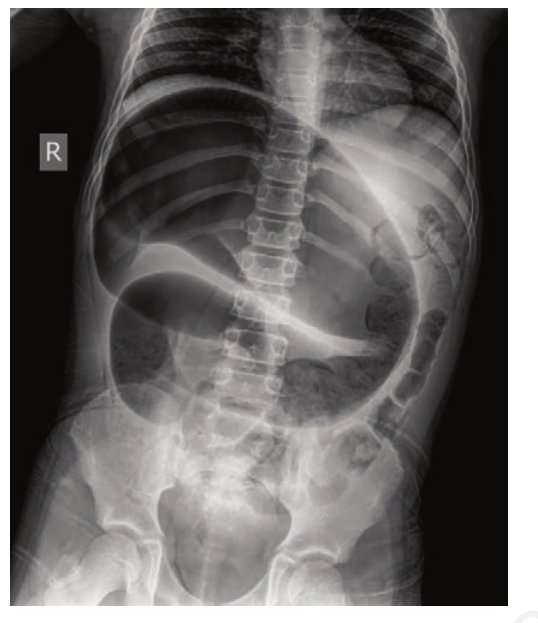
Figure 1. Erect abdominal X-Ray, showing a hugely enlarged colic area, without free air in the peritoneal cavity.